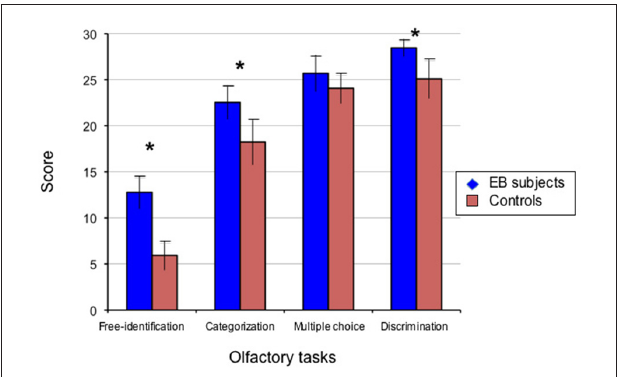
FIGURE 1 | Performance of early blind (EB) subjects and controls in psychophysical olfactory testing. The perceptual aspects of olfaction were investigated in 13 subjects with early-onset blindness (EB) and 13 sighted controls (SCs) studied blindfolded, using a set of 30 commercially available bottles that contained microencapsulated granules of odorants selected by a perfumer (http://www.sentosphere.fr). Odorants (flower, fruit, plant or domestic elements) were presented orthonasally in one single session. A discrimination task and an identification task with three levels of cuing, i.e., free identification (no cue), categorization (semantic cue), multiple choice (semantic and phonological cues) were used to assess the olfactory abilities. In each task, the quotation was made on a 0/1 basis (for each trial in the related task, 0: wrong; 1: correct), with the total number of correct responses providing the score (maximum: 30/30). Histograms display the mean values and standard deviations of these scores for EB subjects and matched SCs as indicated. The group difference was significant ( ∗ p < 0.05) in all conditions except multiple choice identification. EB subjects significantly outperformed the SC participants in odor discrimination ( p < 0.0002), free-identification ( p < 0.0001) and categorization ( p < 0.0004). The multiple choice identification scores showed a trend to a slightly better performance in the EB subjects compared to the blindfolded controls, though not significant ( p = 0.063). Adapted from Cuevas et al.